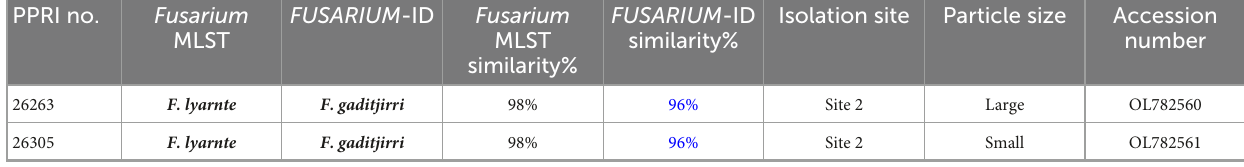
TABLE 8 Nucleotide BLAST (nBLAST TM ) results from the Fusarium MLST and FUSARIUM -ID databases for the FNSC. PPRI